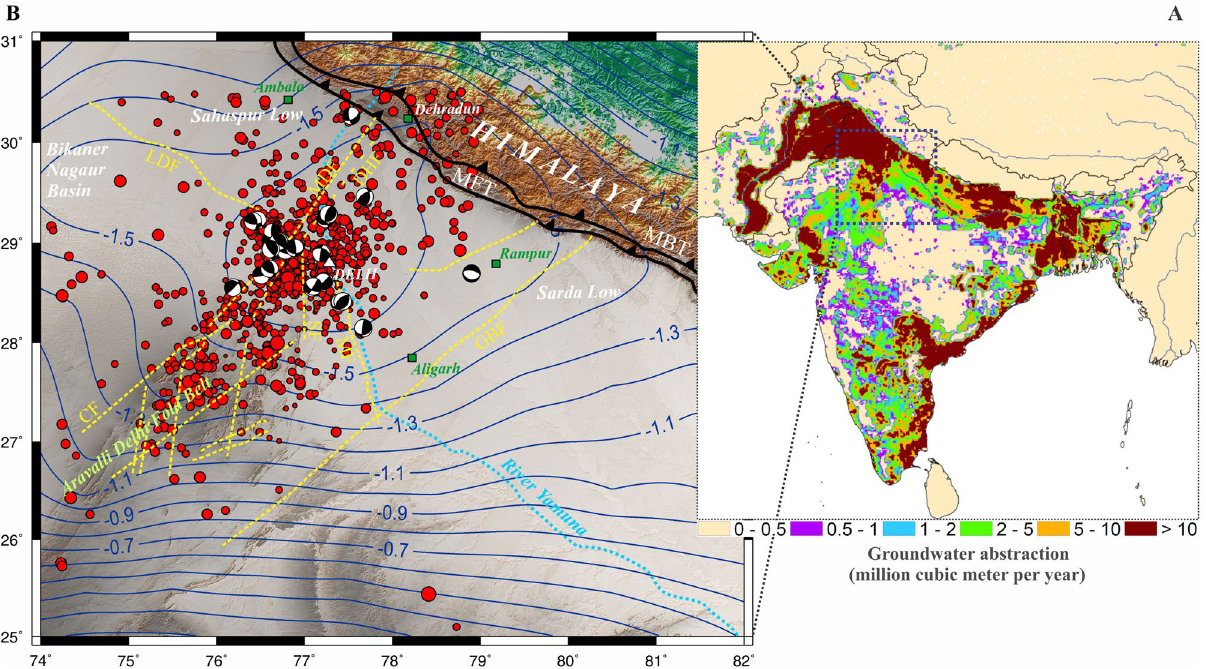
Figure 1. Groundwater extraction from the Indo-Ganga plain, Delhi surrounding region and Aravalli Delhi fold belt associated seismicity. (A) The groundwater pumping rate of the Indian subcontinent derives from International Groundwater Resources Assessment Center (IGRAC) and after that it was downscaled to grid scale using the deficit of surface water availability over the total water demand as a proxy. Note groundwater abstraction rate is highest in the Indo-Ganga plain and Delhi surrounding region. (B) Rate of groundwater depletion of the region (marked by white box in A ) derived from GRACE and GLDAS (contours in cm/year). Note the Aravalli Delhi fold belt associated seismicity lies in the region of maximum groundwater depletion (~ 1.6 cm/year). Different basement faults are marked by dashed lines 38 . MDF Mahendragarh Dehradun Fault, CF Chahapoli Fault, SF Sohna Fault, MF Mathura Fault, GBF Great Boundary Fault, DHF Delhi Haridwar Fault, MBT Main Boundary Thrust, MFT Main Frontal Thrust. This figure was generated using Generic Mapping Tools (version 5.2.1; URL: